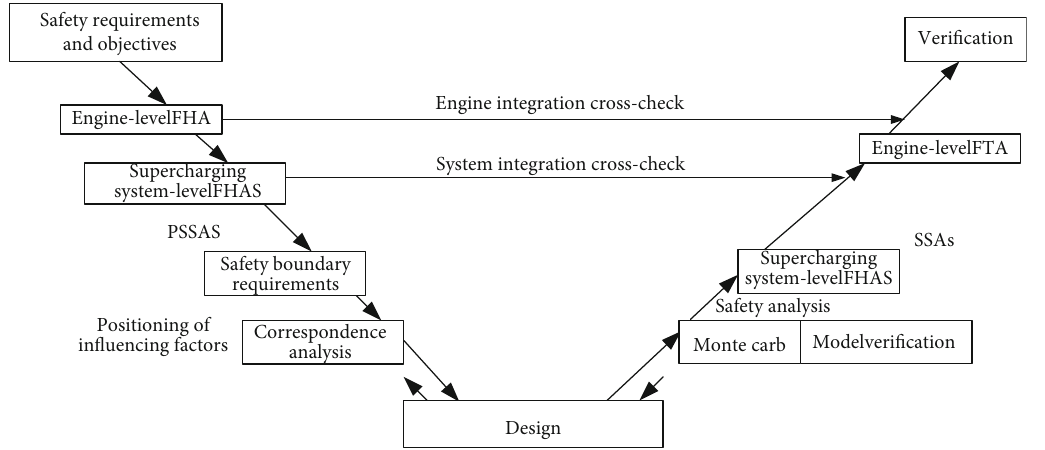
Figure 2: Model-based safety assessment process for the engine and its